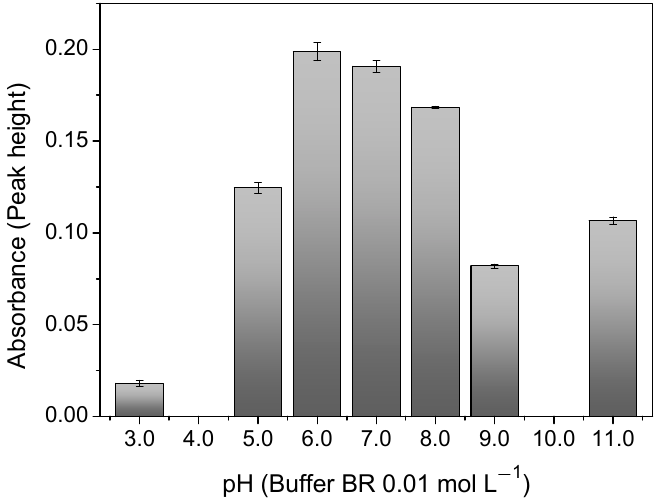
Figure 5. Effect of pH on Cu 2+ absorbance signal with a buffer of 0.01 mol L − 1 of BR, using the poly- mer in the FIA system. Conditions: mass of polymer = 50.0 mg; concentration of Cu 2+ = 100.0 µg L − 1 ; sample volume = 14.0 mL; preconcentration/elution flow rate = 7.0 mL min − 1 ; eluent = 1.50 mol L − 1 HCl.